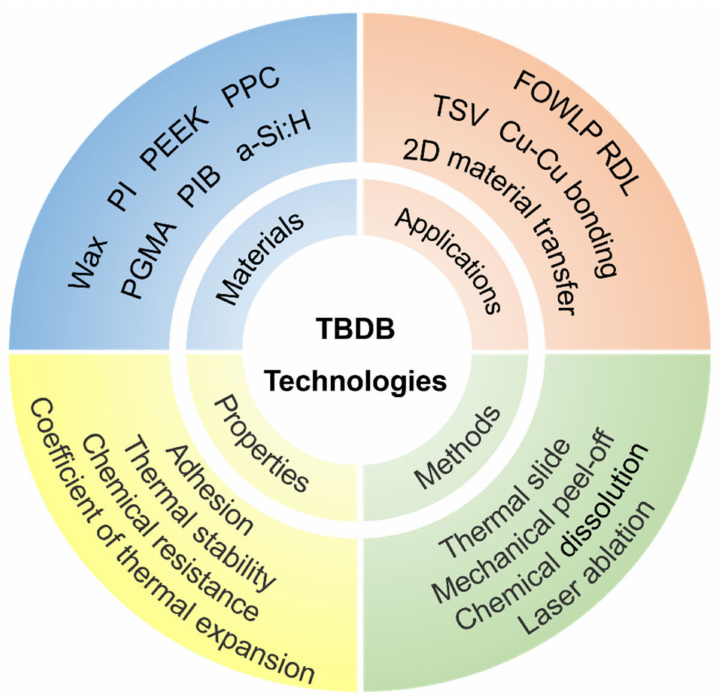
Figure 1. An overview of the different TBDB technologies for advanced